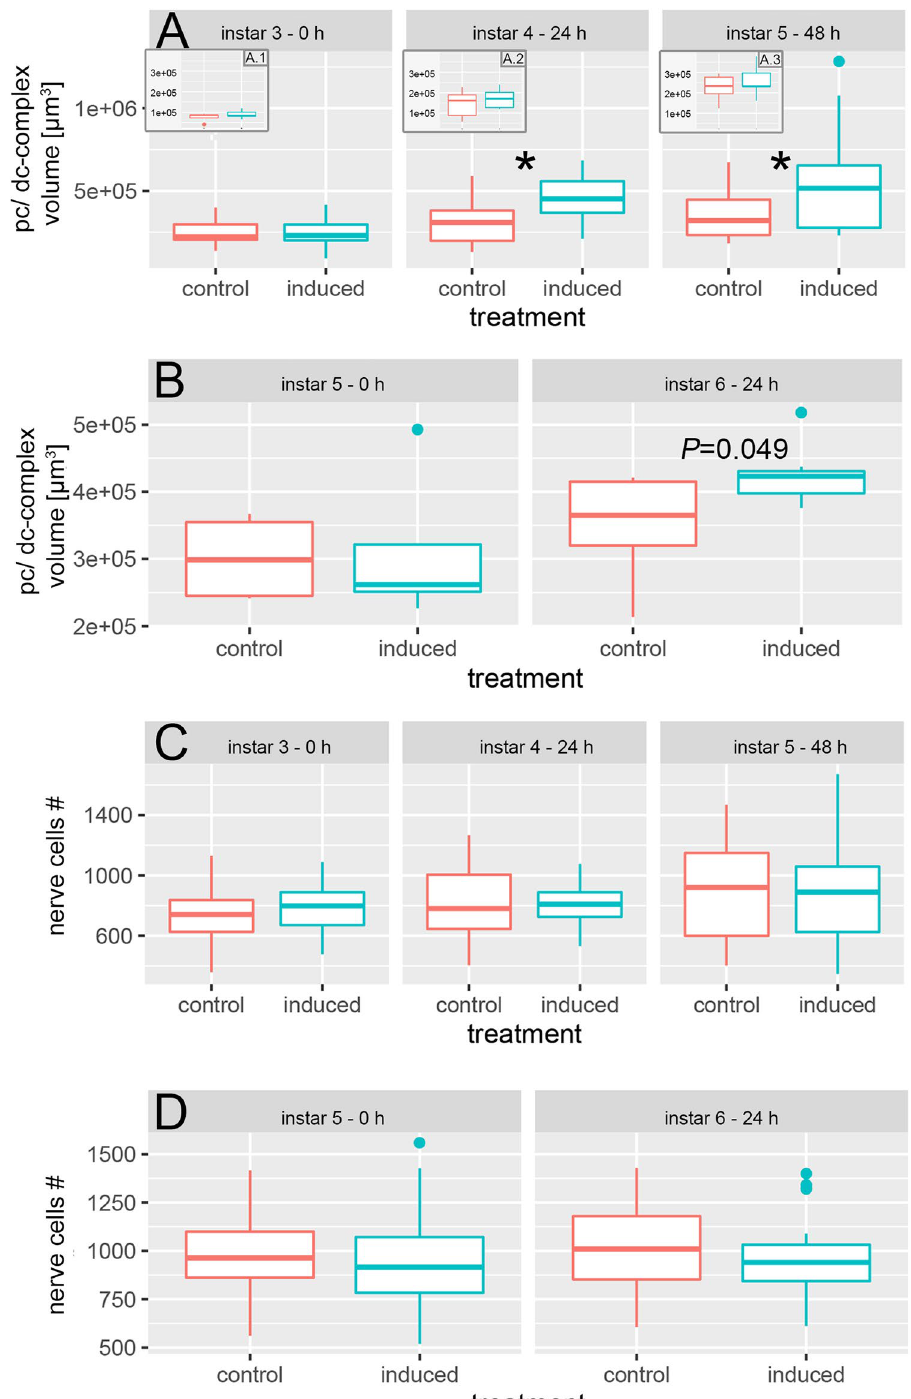
Figure 3. Structural plasticity underlying morphological defense expression ( A ) 24 h predator exposure starting from the 3rd instar, significantly induced an increase in pc/dc-complex volume compared to the controls ( P = 0.011; t = 2.73; df = 28). This increase was also observed after 48 h predator-exposure ( P = 0.014; t = − 2.59; df = 33). (A . 1 , A . 2 , A . 3) . We detected no significant differences in OG volume between treatments. We observed a significant increase in OG volume between instar 3 and instar 5 in both treatments (control ANOVA: F (2;13) = 9.63 P = 0.003 Tukey: P = 0.002; induced ANOVA: F (2;14) = 12.07 P = 0.001 Tukey: P ≤ 0.001). Alpha corrected levels of significance: * P ≤ 0.017; ( B ) When exposed to predators from the 5th instar onwards, the pc/dc-complex volume shows a tendency towards an increase after 24 h predator exposure compared to the control ( P = 0.049; t = − 2.19; df = 12) and to the 5th instar ( P = 0.036; t = − 2.42; df = 10) Alpha corrected levels of significance: * P ≤ 0.025. ( C ) We detected no significant differences in nerve cell numbers between treatments. We found a tendency towards an increased nerve cell number in naïve individuals in the 5th instar compared to the 3rd instar, when the animals were exposed to predators from the 3rd instar onwards (ANOVA: F (2;98) = 2.64 P = 0.077 Tukey: P = 0.076) Alpha corrected levels of significance: * P ≤ 0.025. ( D ) When exposed to predators from the 5th instar onwards, we find no differences in nerve cell numbers between treatments or instars. Alpha corrected levels of significance: * P ≤